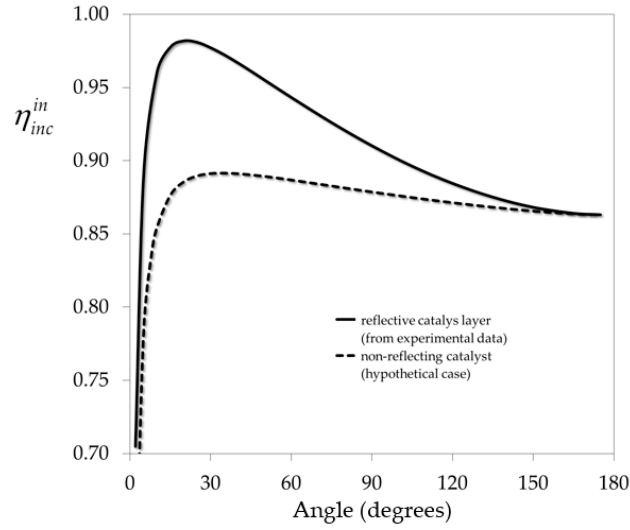
Figure 6. Inner incidence efficiency as a function of folding angle. Reprinted with permission from